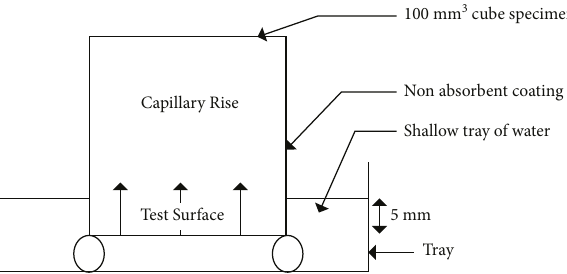
Figure 5: Arrangement for the rate of absorption (Sorptivity)